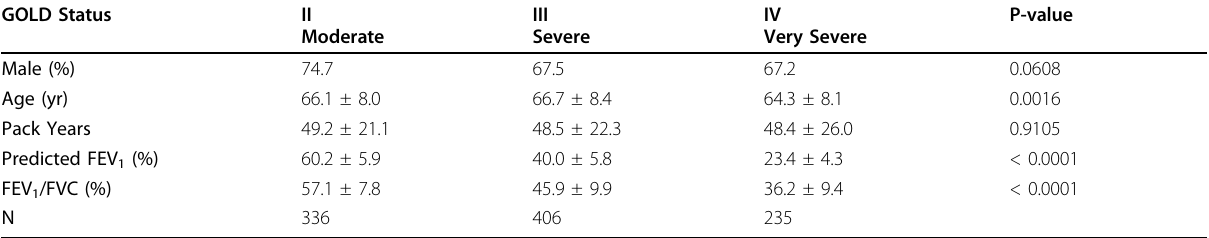
Table 3 Characteristics of COPD patients according to GOLD classification of disease